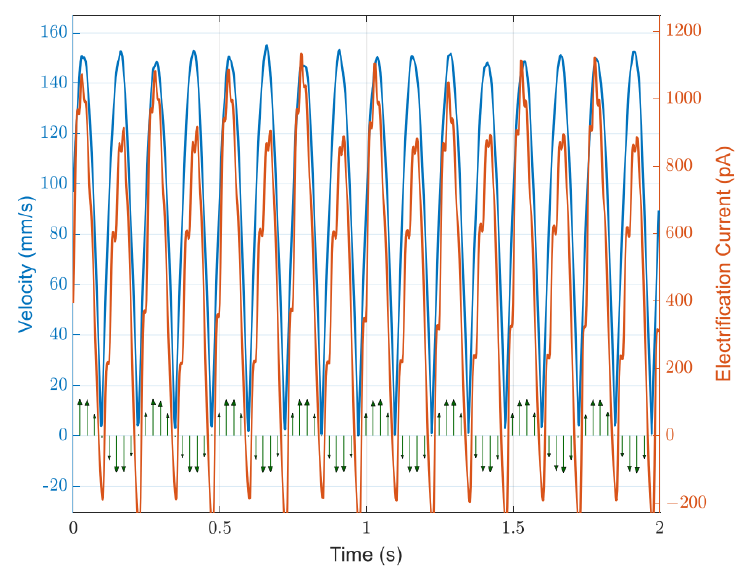
Figure 8. Intermittent shuttle velocity signal and generated electrification current. The top electrode swings with a frequency of 4 Hz. Black lines show the direction of electrode movement.